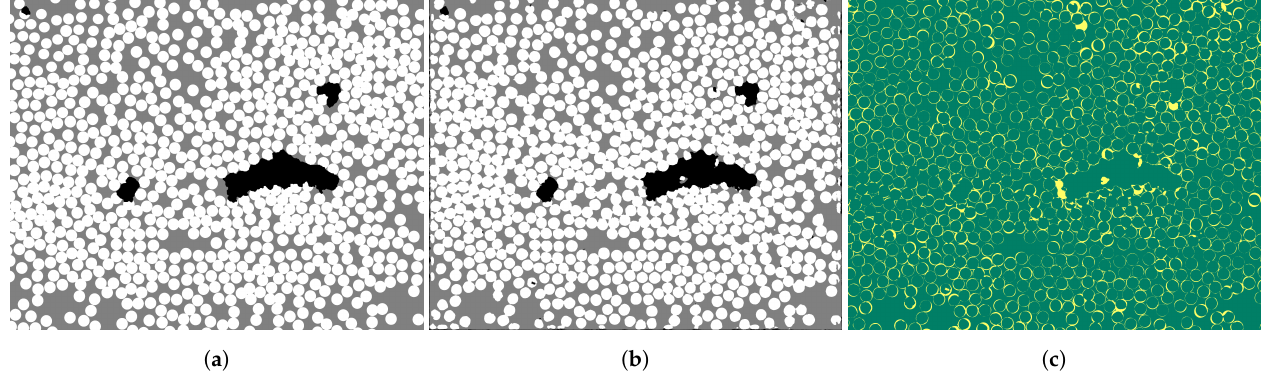
Figure 8. VI1 ( a ) ground truth, ( b ) predicted segmented micrograph, and ( c ) wrong and correct predicted pixels in yellow and green, respectively. Table 7. Wrong Prediction Matrix for VI1.